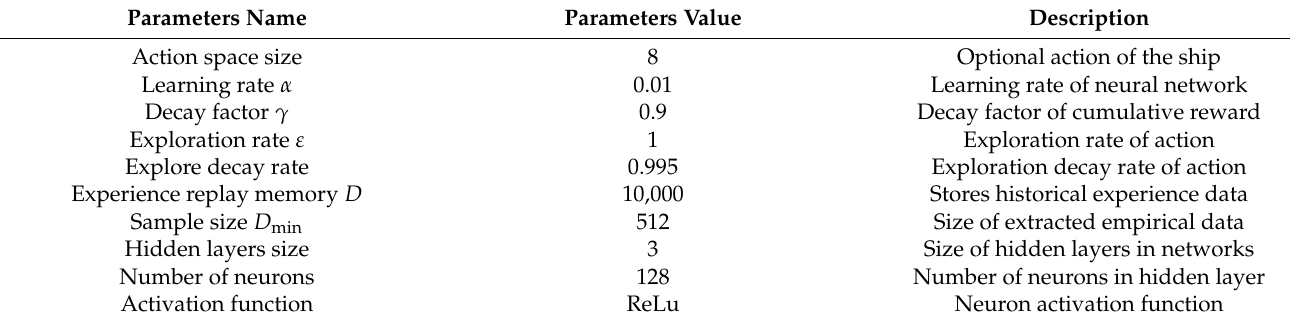
Table 1. Model training parameter